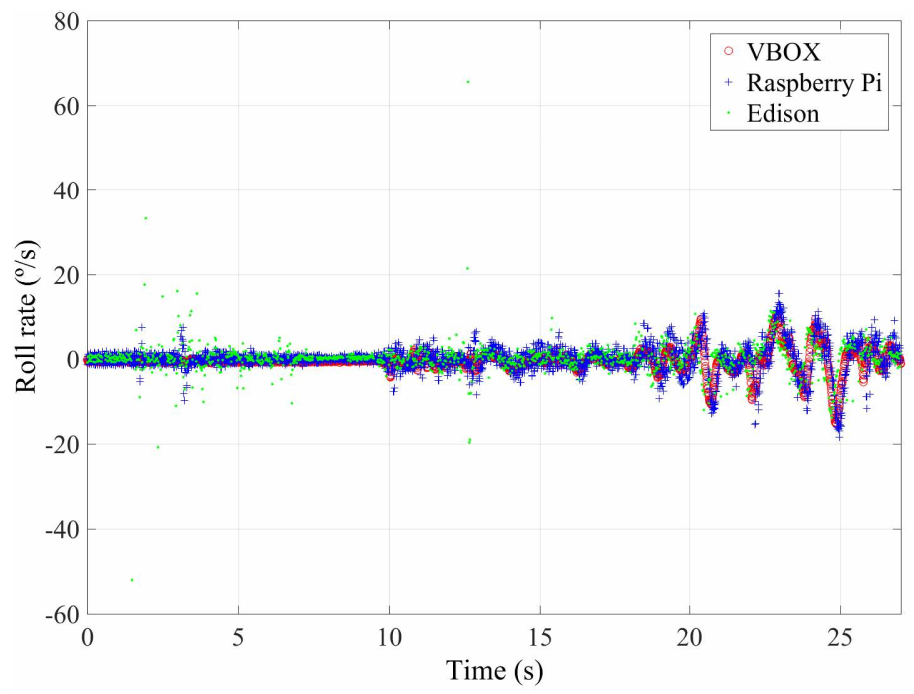
Figure 12. Test 2: Roll rate obtained from the IMU of VBOX (red points), from the IMU of Raspberry pi (blue points) and from the IMU from Intel Edison (green